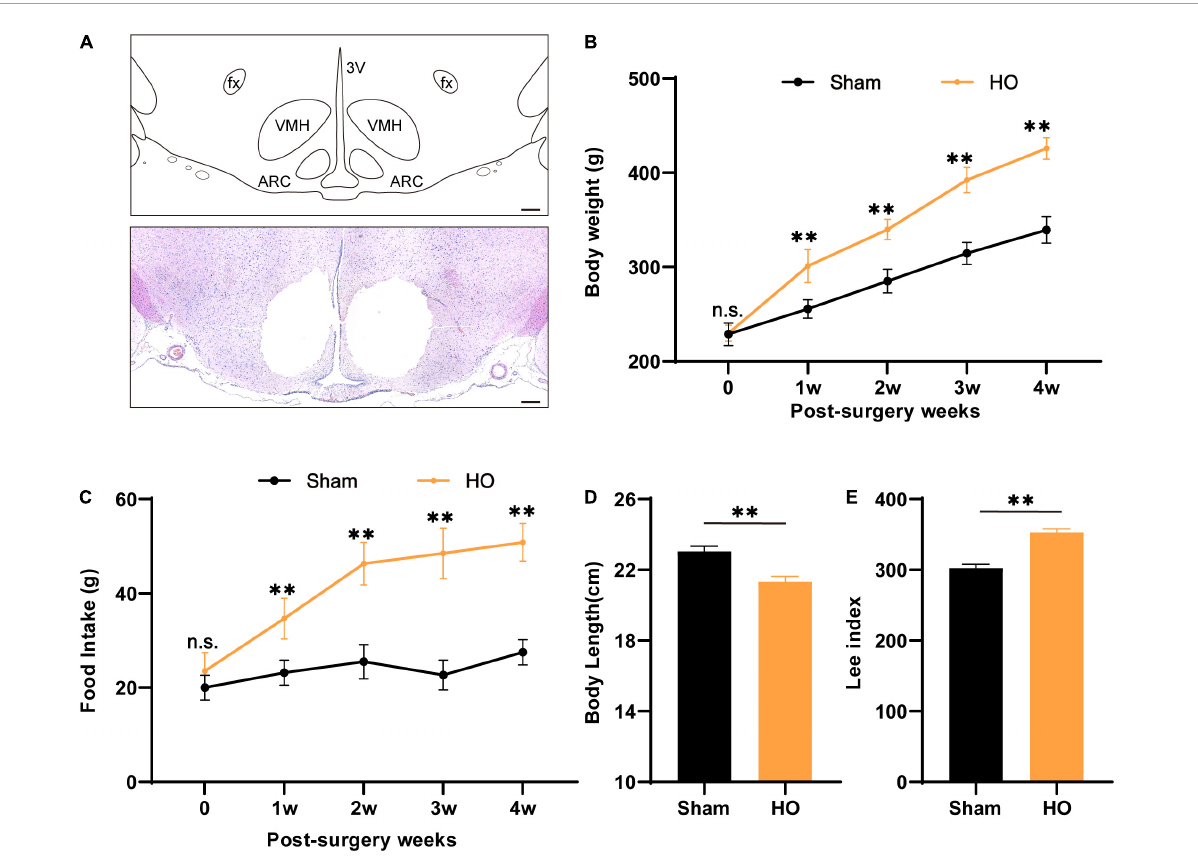
FIGURE1 Characteristics of biological parameters after ARC and VMH lesion surgery. (A) Schematic overview of the mediobasal hypothalamus and coronal brain sections (–2.6 mm from the bregma) from electrolytic lesions in the ARC and VMH. Scale bars, 200 µ m. (B,C) Dynamic changes in postoperative body weight and food intake of rats in the sham-operated group and HO group during the experiment, n = 6, ∗∗ P < 0.01 vs. sham-operated group. (D,E) Body length and Lee’s index of rats in each group at 28 day after operation, n = 6, ∗∗ P < 0.01 vs. sham-operated group. All data are presented as the M ± SD of each group. ARC, arcuate nucleus; VMH, ventromedial nucleus of the hypothalamus; 3V, 3 ventricle; fx: fornix